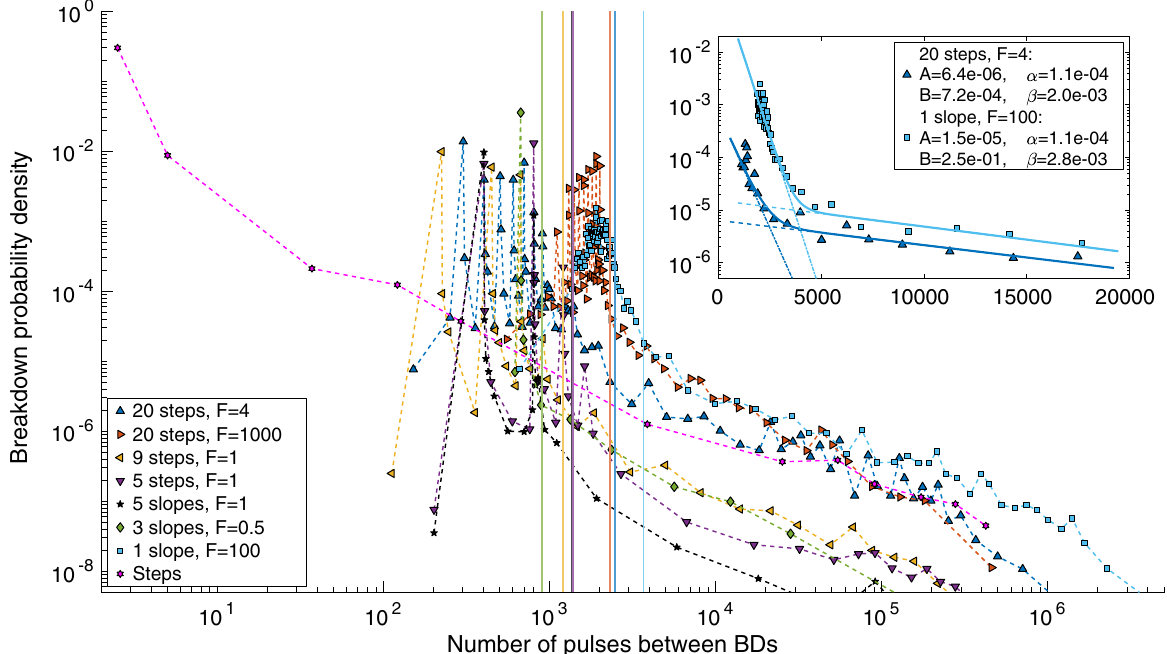
FIG. 4. Probability for a breakdown to occur at each number of pulses between breakdowns for each of the ramping scenarios. The vertical lines indicate the cross points of the two-exponential fit for each run. A visualization of the fit for the data points of 20 steps, F ¼ 4 and 1 slope, and F ¼ 100 is shown in the inset. There, the legend also shows the fit